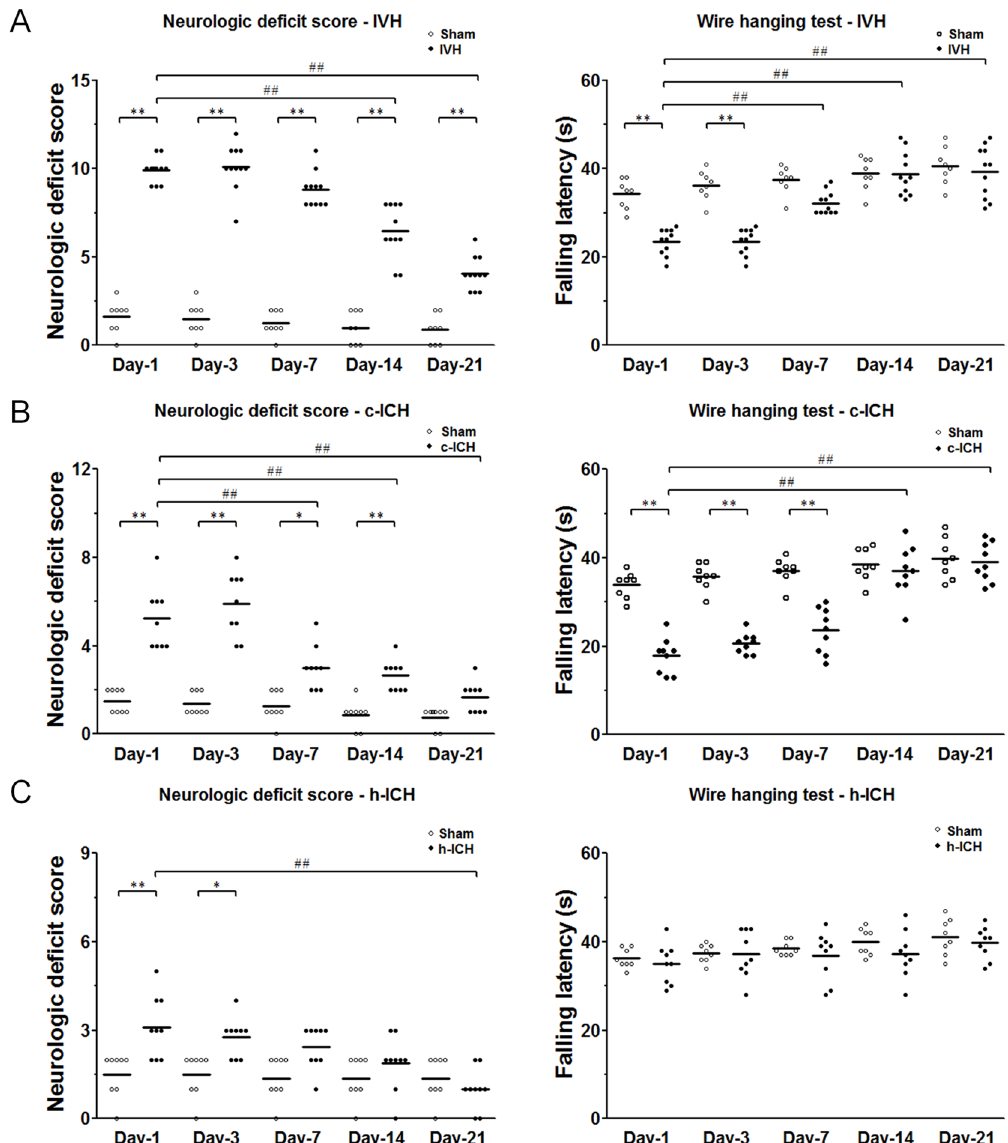
Figure 7. Changes in locomotor function after intracerebral hemorrhage (ICH) in ventricle, cortex, and hippocampus. Locomotor deficits were measured by a 24-point scoring system, in which higher scores indicate greater deficit, and by the wire-hanging test, which measures gripping and forelimb strength. (A) Mice in the IVH group had significantly greater motor deficit than did mice in the sham group at all time points after IVH (n=11 mice per group, F =138.3, all p , 0.01) and showed gradual recovery from day 7 to day 21 post-ICH. Gripping and forelimb strength were significantly impaired in the IVH mice on days 1 and 3 after IVH (n=11 mice per group, F =27.72, both p , 0.01). (B) Mice in the c-ICH group had significantly greater motor deficit than did mice in the sham group on days 1, 3, 7, and 14 after c-ICH (n=9 mice per group, F =35.31, p , 0.05). Gripping and forelimb strength were significantly impaired in the c-ICH mice on days 1, 3, and 7 after c-ICH (n=9 mice per group, F =37.29, p , 0.01). (C) Mice in the h-ICH group had significantly greater motor deficit than did mice in the sham group on days 1 and 3 post-ICH (n=9 mice per group, F =6.911, p , 0.01 [day 1] and p , 0.05 [day 3]). Gripping and forelimb strength were not significantly different between the h-ICH and sham groups at any time point studied (n=9 mice per group, F =1.803, all p . 0.05). Values are means 6 SD; * p , 0.05, ** p , 0.01 vs. sham group; ## p , 0.01 vs. IVH,